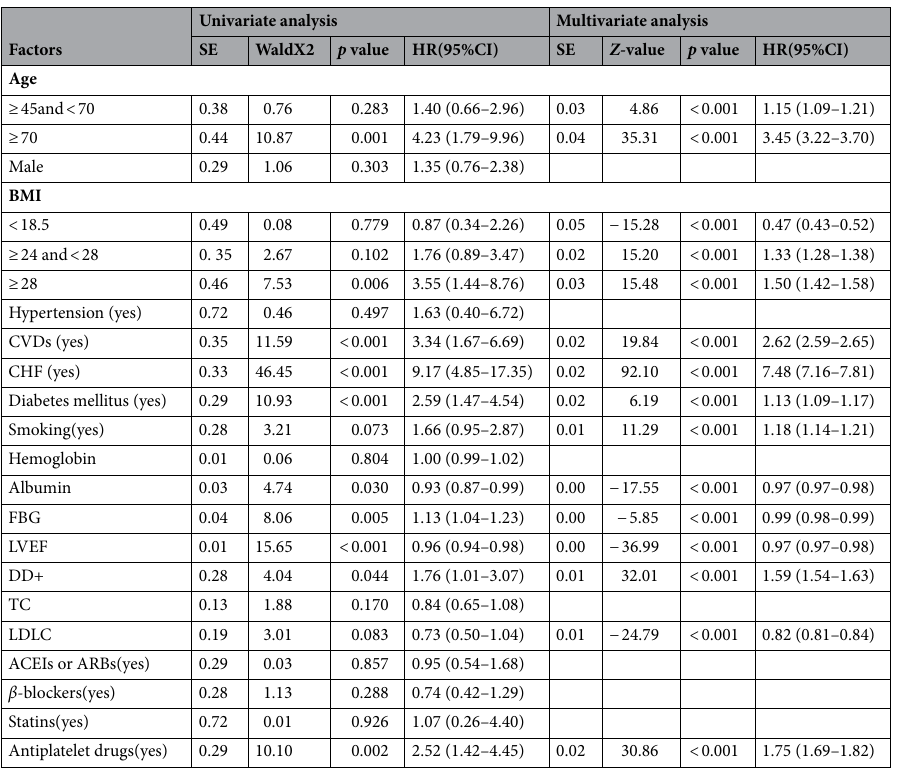
Table 2. Univariate analysis by Cox proportional hazard analysis and multivariate analysis by bootstrap for primary endpoint. SE, standard error; HR, hazard ratio; CI, confidence interval; BMI, body mass index; CVDs, cardiovascular diseases; CHF, chronic heart failure; FBG, fasting blood glucose; LVEF, left ventricular ejection fraction; DD+, diaphragm dysfunction; TC, total cholesterol; LDLC, low density lipoprotein cholesterol; ACEIs, angiotensin converting enzyme inhibitors; ARBs, angiotensin receptor